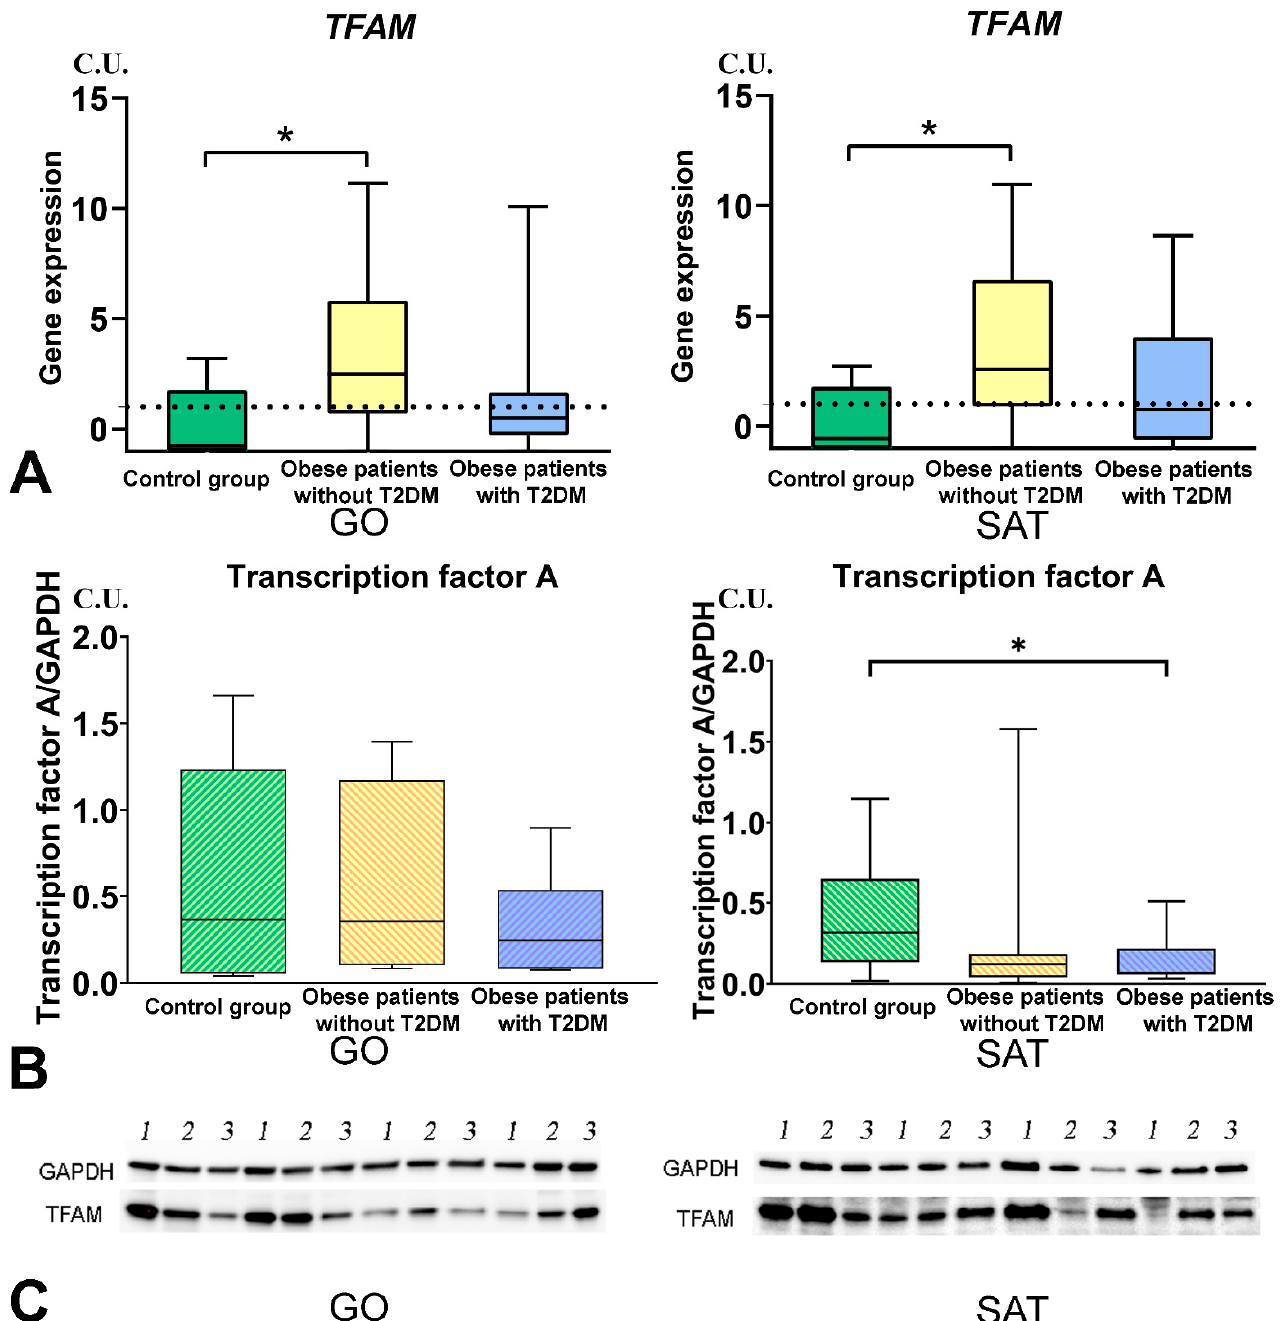
Figure 8. Study of tissue-specific production of TFAM in obese patients with and without T2DM. ( A )—TFAM genes expression in GO and SAT, n = 25; ( B )—Transcription factor A protein production in GO and SAT, Western blot analysis of AT biopsies, n = 8; ( C )—Protein TFAM Western blot bands, n = 8. *— p < 0.05 significance is determined using the Mann–Whitney criterion for two independent samples.